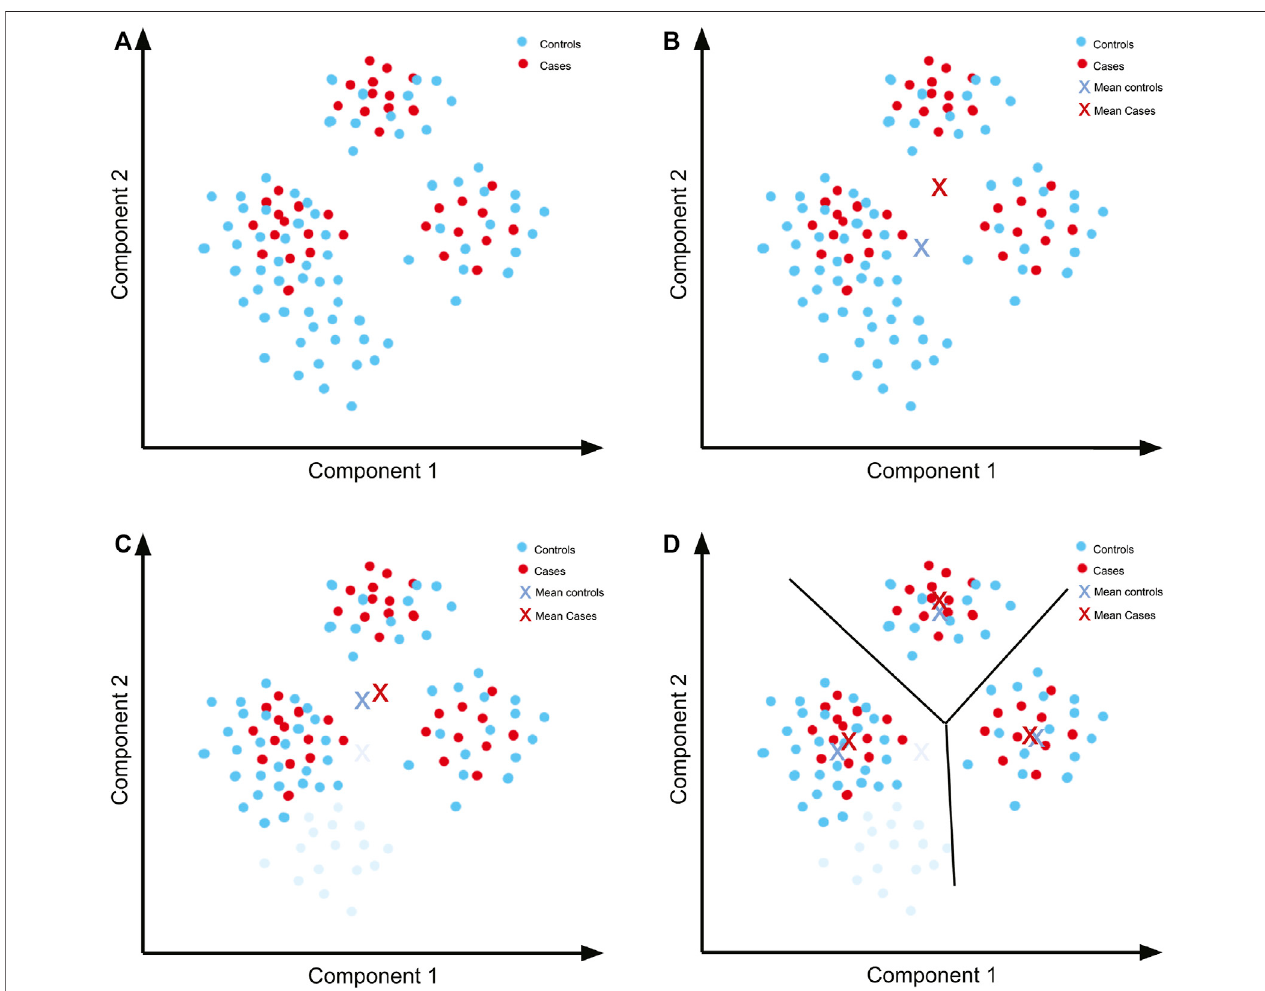
FIGURE 4 | Quality control previous to performing a GWAS. (A) Hypothetical PCA plot for a simple dataset. There are three separate populations including both casesandcontrols. (B) Themeansofthecomponentsforcasesandcontrolsarenotclosebecausethereisaconcentrationofcontrolsinanareawithnorepresentation from cases. (C) Byremovingthecontrolsthat arenotwell represented inthecases(lightblue),wecanget ameanthatiscloser tothemean ofthe cases. (D) The means are closer when separating by the observed populations, so these can then be analysed separately and the results subsequently combined.